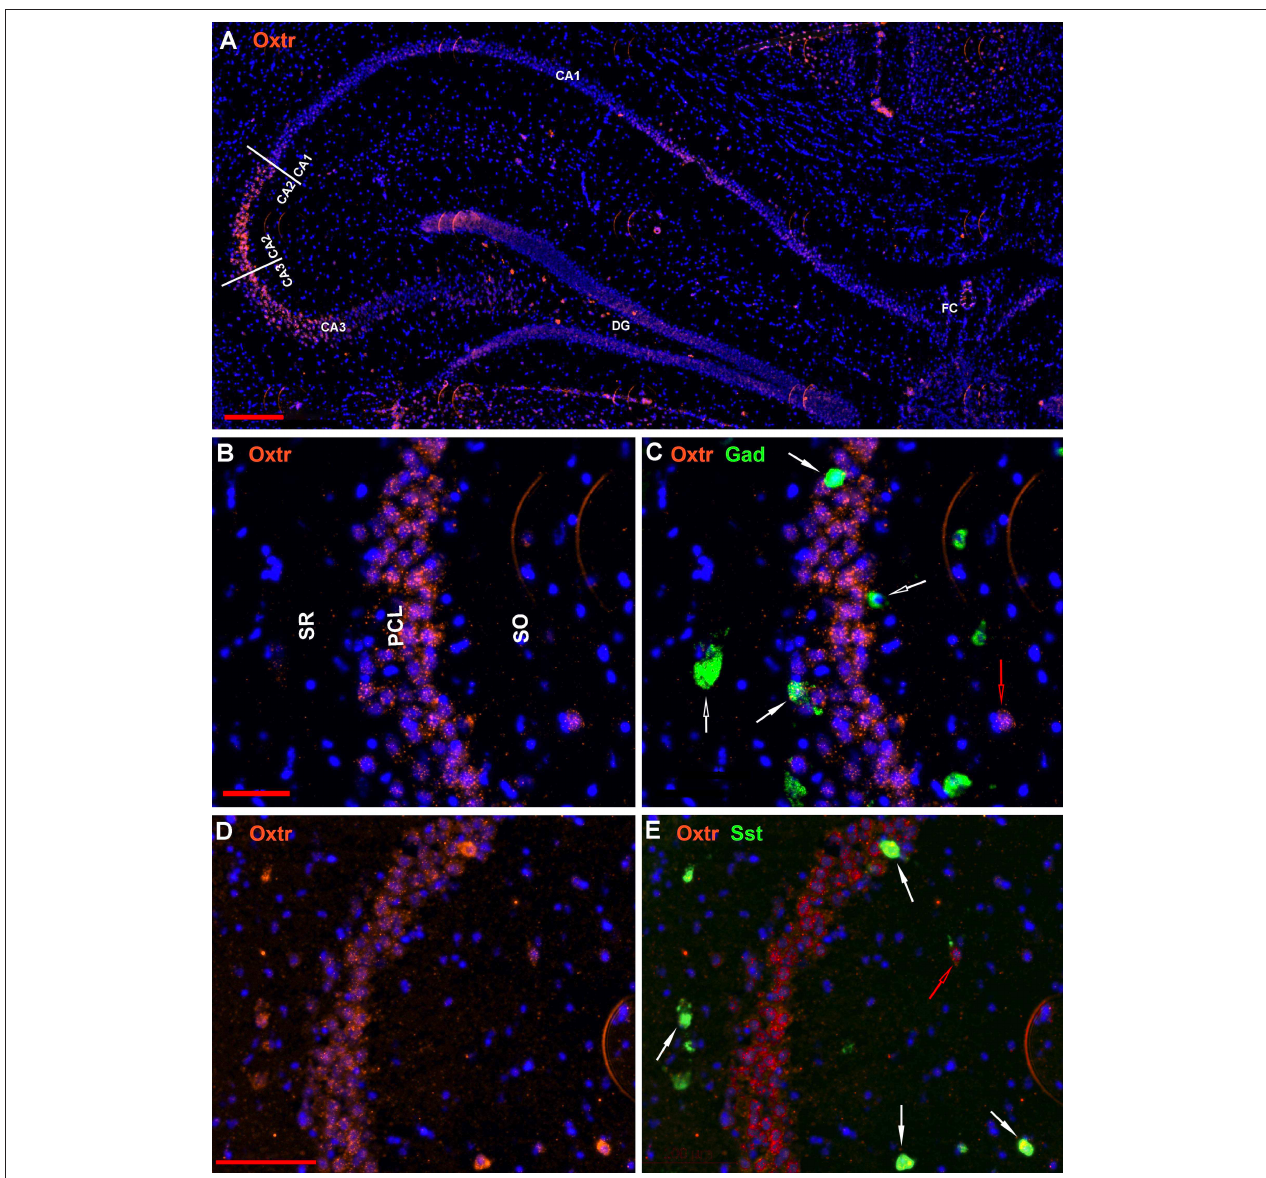
FIGURE 5 | Examples of the distribution of Oxtr neurons within the hippocampus. (A) shows the distribution in a low magnification view (scale bar equals 200 µ m). (B) shows higher magnification within the CA2 region and (C) shows the Oxtr colocalization with Gad-1 [scale bar of 50 µ m for (B,C) ]. (D) shows higher magnification within the CA2 region and (E) shows the Oxtr colocalization with Sst [scale bar equals 100 µ m for (D,E) ]. Solid white arrows indicate colocalization of Oxtr transcripts with the INM transcripts. Open white arrows indicate only expression of the INM. Open red arrows indicate only expression of Oxtr.